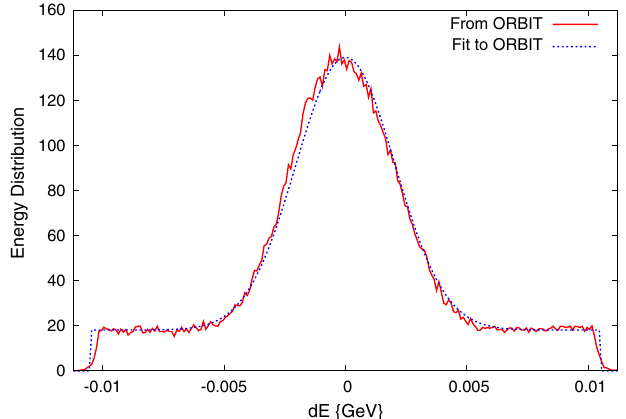
FIG. 5. The red curve shows the energy distribution of the SNS coasting beam obtained from the ORBIT injection simulation. The blue points show the fit of the analytic functions (rectangle plus Gaussian) to the simulation.